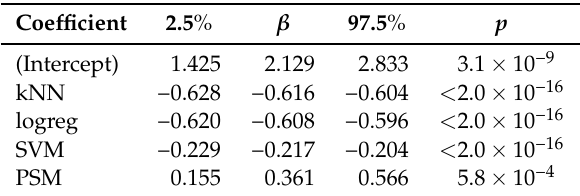
Table 3. GLMM (Generalised Linear Mixed Effects Model) estimates ( β ), 95% confidence intervals, and p -values of the fixed effects on subject-dependent performance associated with learning algorithms and personalisation–generalisation